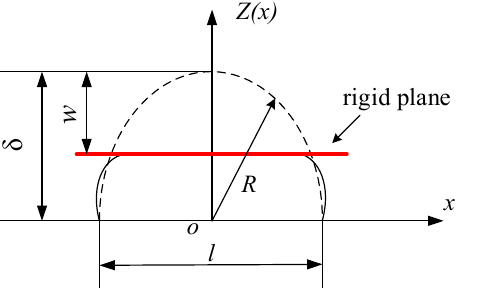
Figure 4. Schematic diagram of contact between the rigid plane and single asperity.